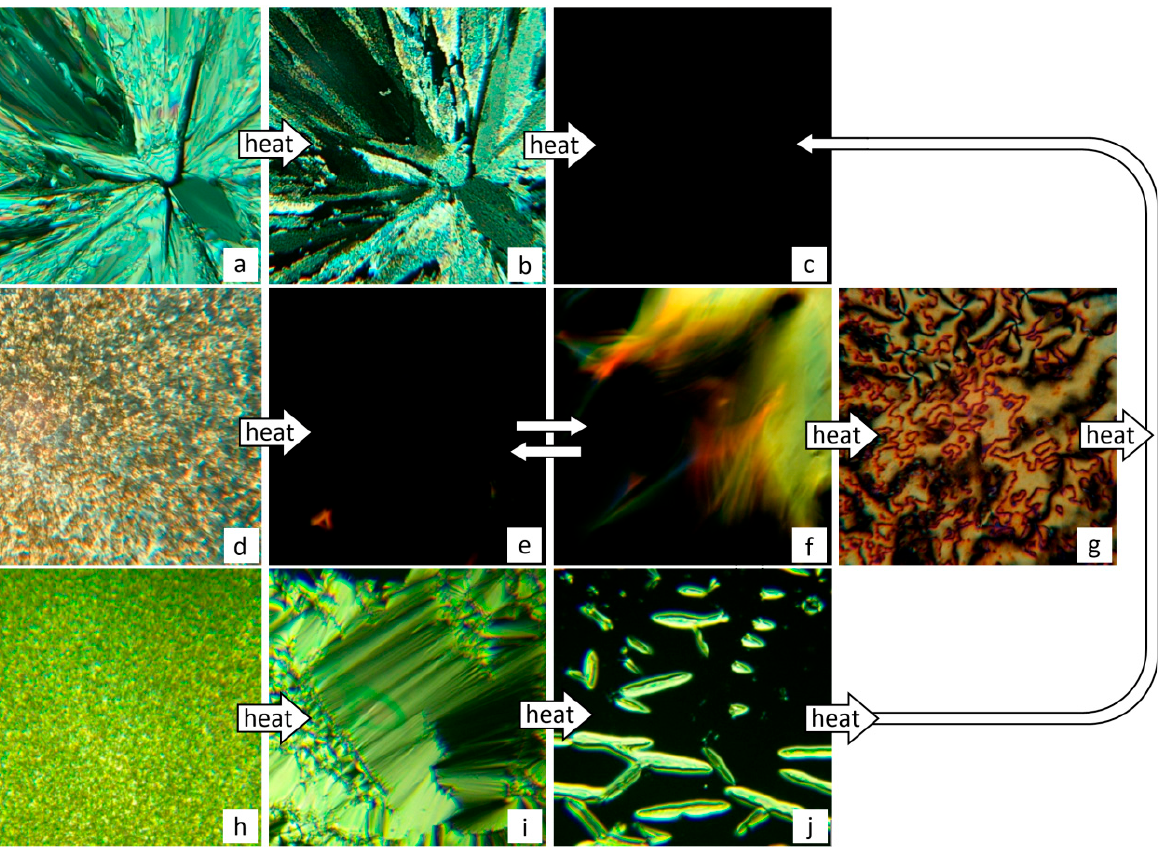
Figure 7. 500 × 500 µm POM textures of monomers BVK at 25 ( a ), 61 ( b ), and 70 ° C ( c ); TVK at 25 ( d ), 131 ( e ), 132 ( f ), 280 ( g ), and 300 ° C ( c ); QVK at 25 ( h ), 120 ( i ), 170 ( j ), and 300 ° C ( c ).